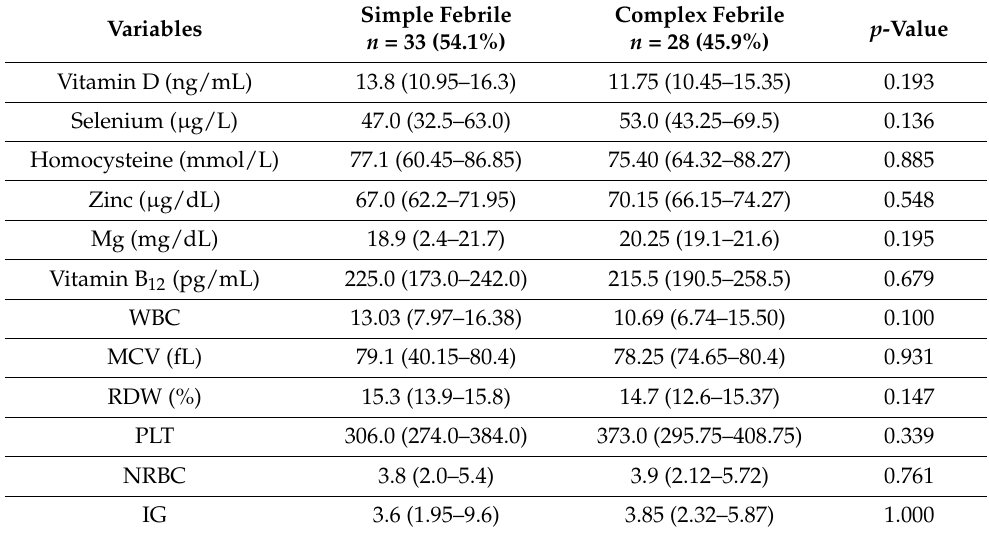
Table 4. Comparison of biochemical and complete blood count parameters of children with simple FS and complex FS.